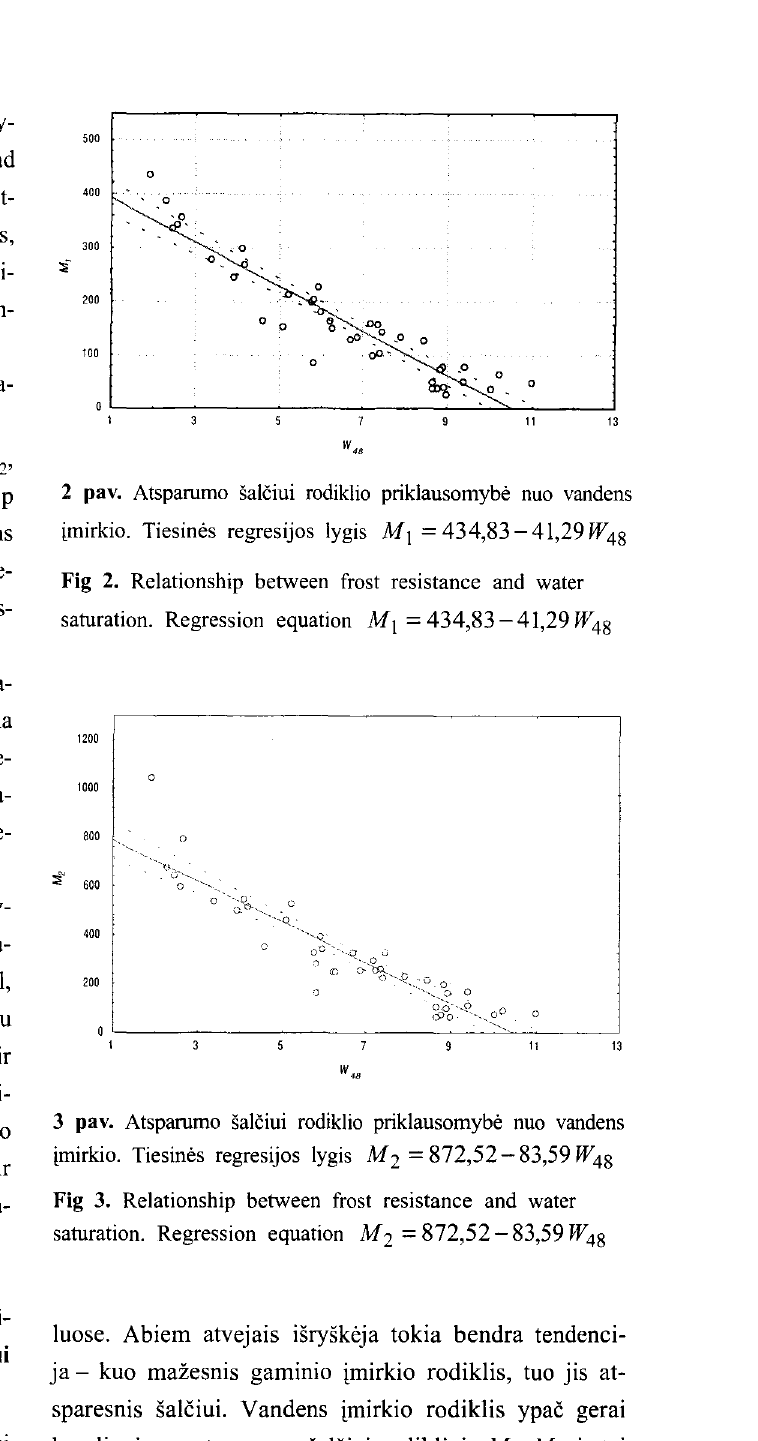
mas keraminiq gaminiq sparciajai atsparumo salciui prognozei